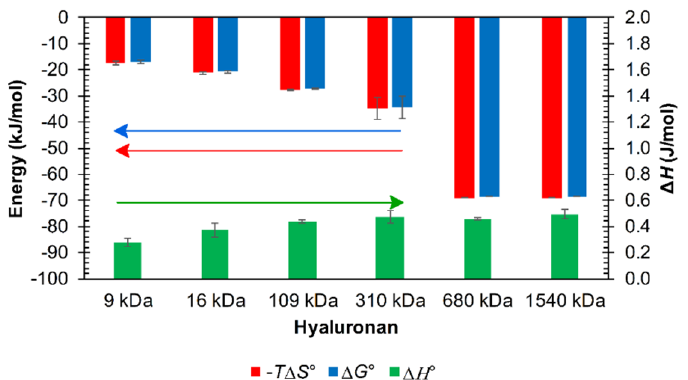
Figure 9. Graph showing the thermodynamic parameters obtained from ITC for the arginine triacontamer in hydrochloride form and hyaluronan of various molecular weights in the environment of PBS.